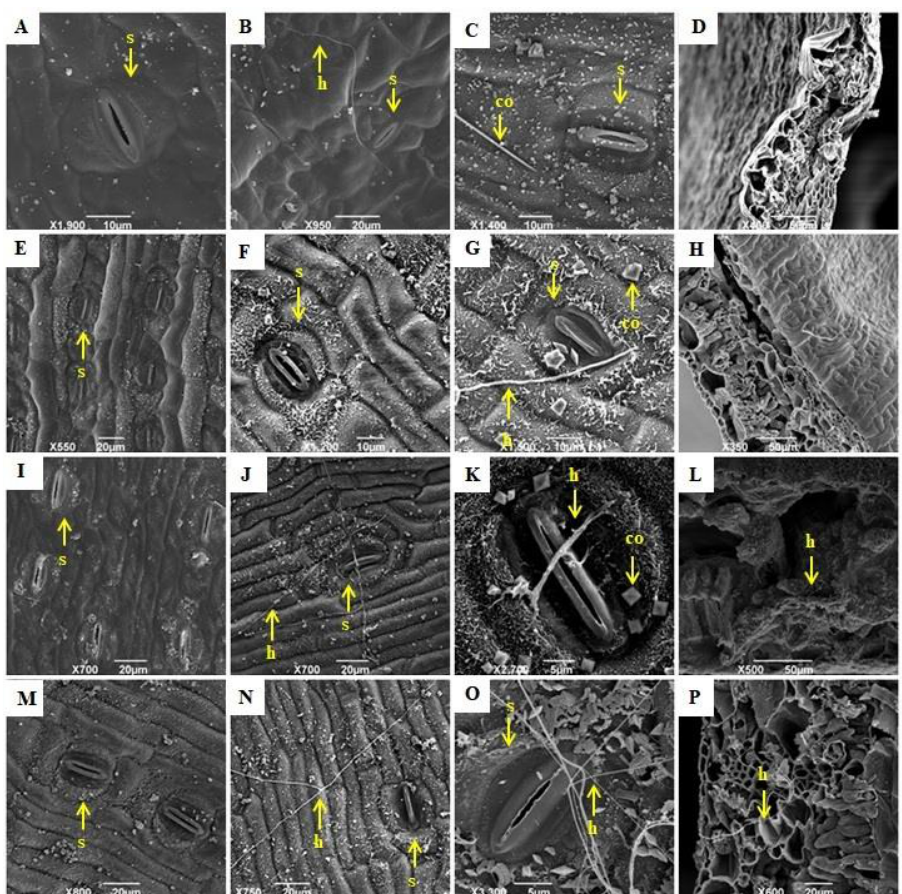
Figure 8. Scanning electron microscopy (SEM) was used to observe the interaction of P. fijiensis on the abaxial surface of leaves of the Calcutta 4 ( A – D ), Krasan Saichon ( E – H ), Grand Naine ( I – L ), Akondro Mainty ( M – P ), banana cultivars. The images were taken at 0 DAI ( A , E , I , M ), 9 DAI ( B , F , J , N ), and 21 DAI ( C , G , K , O , D , H , L , P ). h: Hypha; s: stoma; co: calcium oxalate crystals.